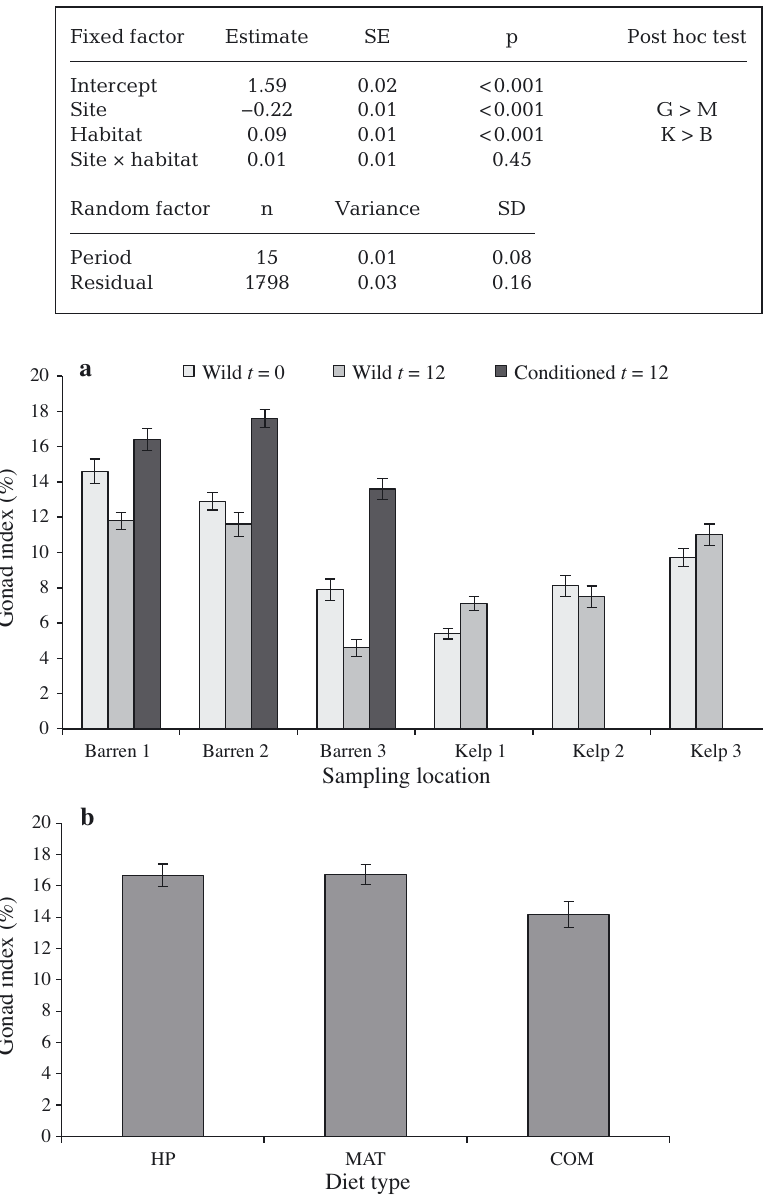
Fig. 3. Expt 2: mean ± SE gonad index of purple sea urchins Heliocidaris erythrogramma (a) from 3 barren sites and 3 kelp-bed sites in Port Phillip Bay, Victoria. Light grey bars: wild urchins collected at the start of the ex- periment (June−July 2016); medium grey bars: urchins collected from the wild 12 wk later (September 2016); dark grey bars: urchins fed gonad- conditioning diets for 12 wk (average of the 3 diets); (b) fed 3 pellet diets for 12 wk: a high-protein diet (HP), a commercially available diet (COM) and a diet which was iso-proteic and iso-lipidic as the COM diet but had a different formulation (MAT; see Table